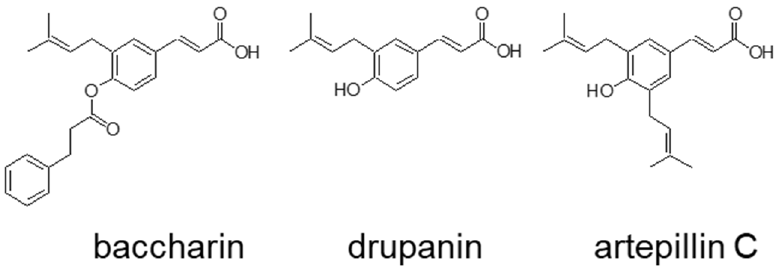
Figure 1. Chemical structure of baccharin, drupanin, and artepillin C. The treatment of cells with artepillin C and drupanin increased the amount of lipid droplets stained by Oil Red O to a similar degree as the PPAR γ ligand rosiglitazone, which served as a positive control (Figure 2a). Baccharin treatment also significantly and dose- numbers of lipid droplets positive for Oil Red O staining (Figure 2a). Moreover, the amount of lipid droplets in cells treated with baccharin was the highest among the three cinnamic acid derivatives from green propolis (Figure